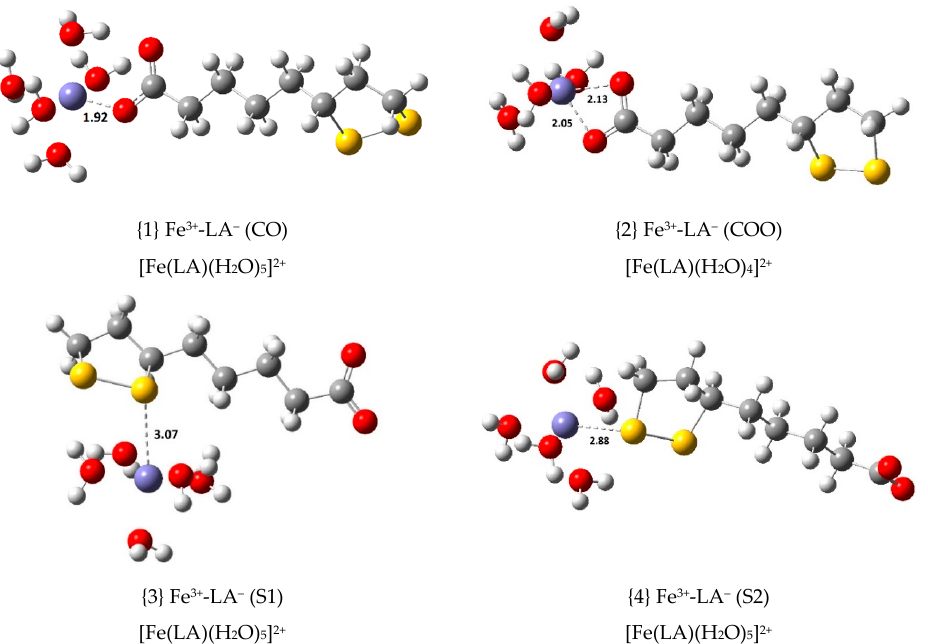
Figure 2. Optimized geometries of the 1:1 complexes of Fe(III) with lipoic acid, LA − (bond distances in Å).